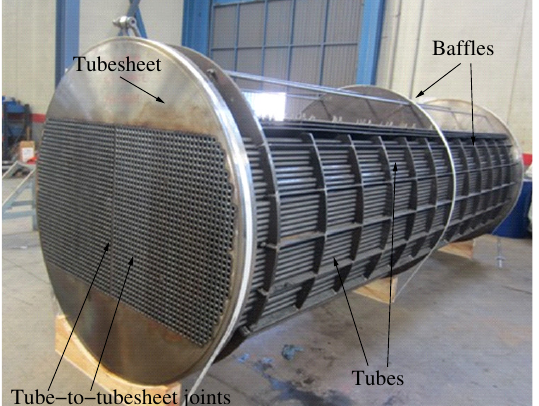
Figure 1. Photograph of some components of a shell and tube heat